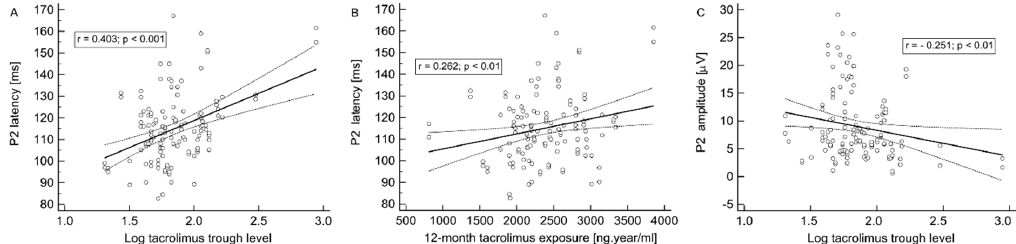
Figure 3. Results of the flash VEP examination. The associations of P2 wave latency and log tacrolimus trough level ( A ) and 12-month tacrolimus exposure ( B ). The association of P2 wave amplitude and log tacrolimus trough level ( C ).